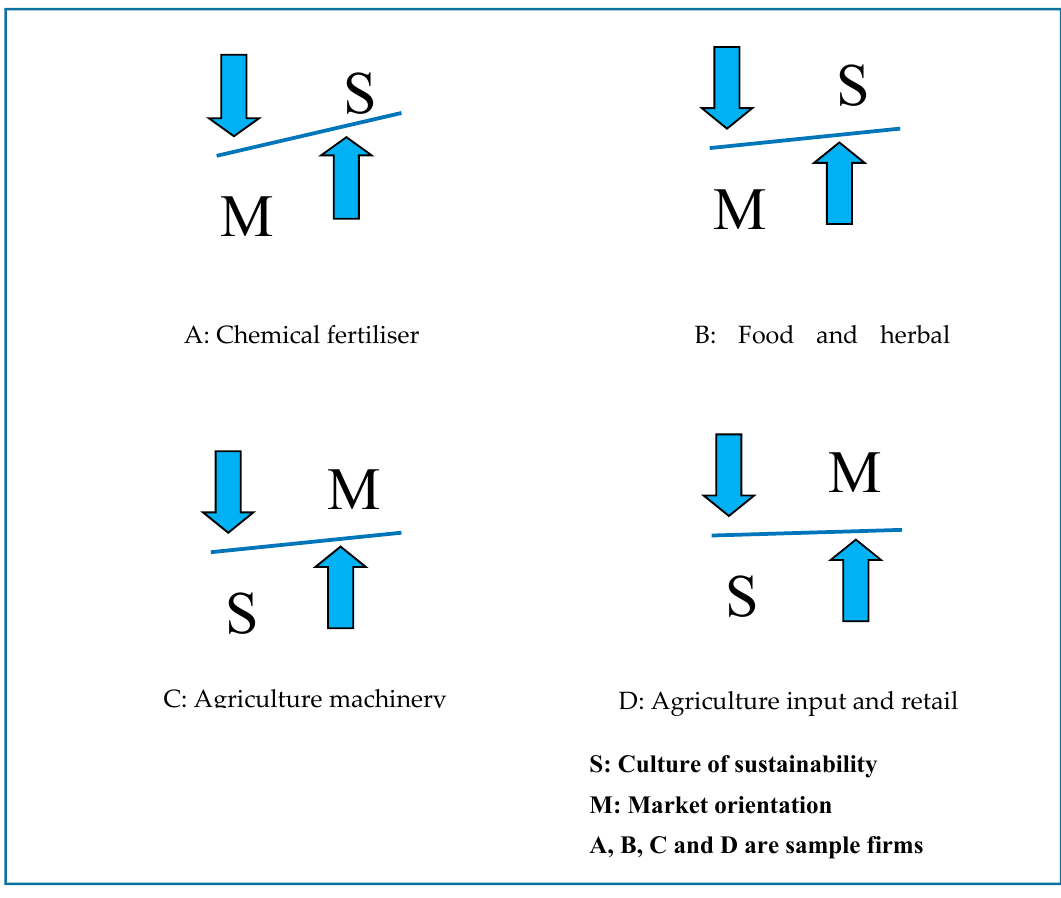
Figure 1. Dominance of Market orientation and Culture of sustainability in agribusiness firms.